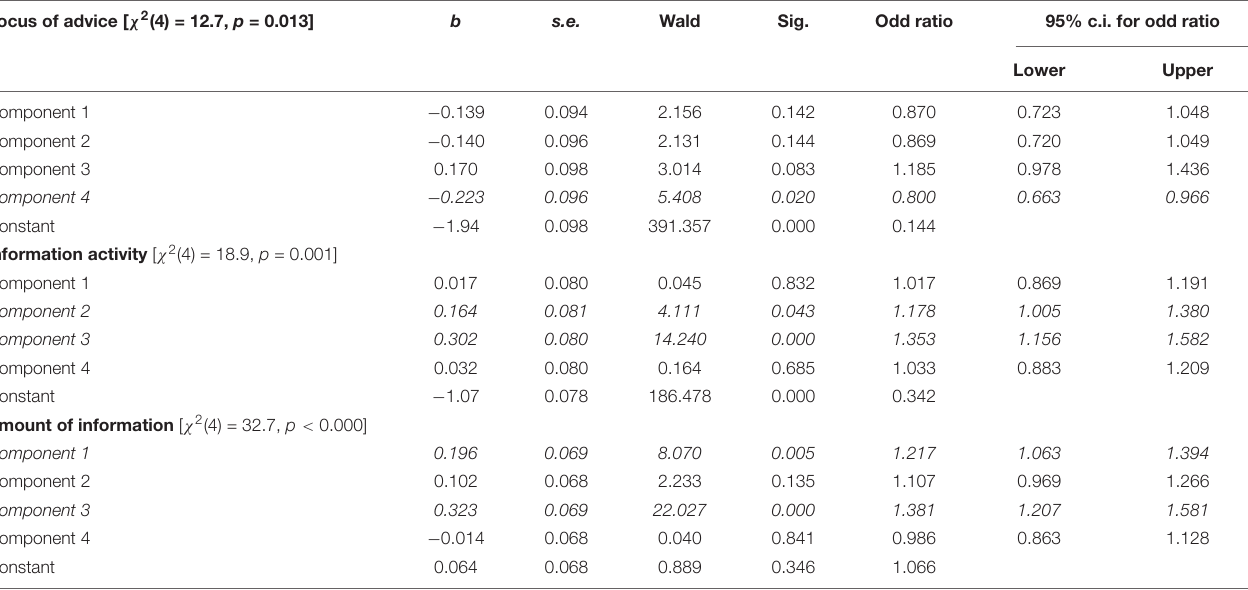
TABLE 3 | Results of the three logistic regressions, Lines holding significant predictions (p < 0.05) italicized [in the table: regression weight b, their standard errors (s.e.), Wald statistics, significance values, odd ratios and the lower and upper borders of the 95% confidence interval for the odd ratios, respectively]. Focus of advice [ χ 2 (4) = 12.7, p =